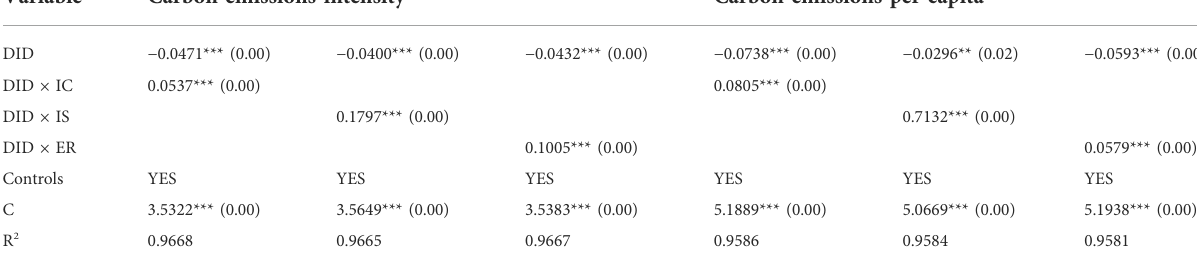
TABLE 3 Regression results of the mechanism of action